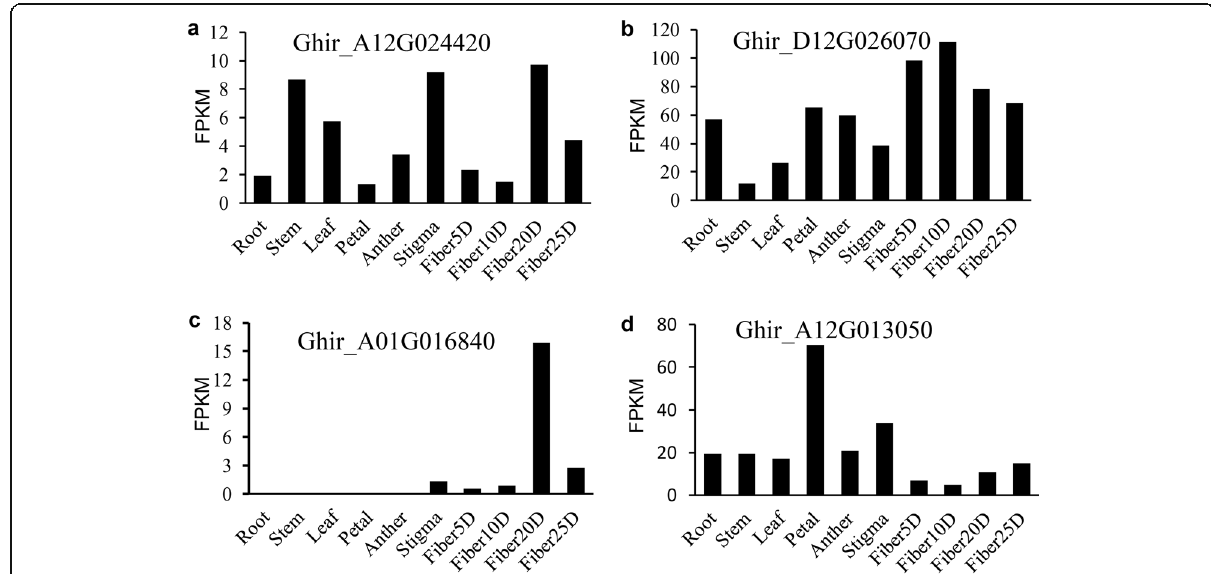
Fig. 7 Expression profiles of candidate genes in various tissues. a . Tissue expression of Ghir_A12G024420. b tissue expression of Ghir_D12G026070. c tissue expression of Ghir_A01G016840. d Tissue expression of